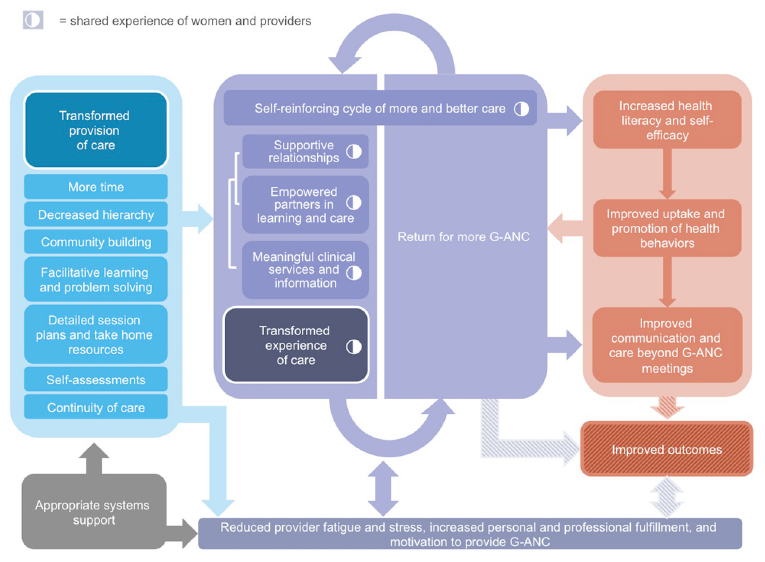
Fig 2. Group antenatal care (G-ANC) theory of change